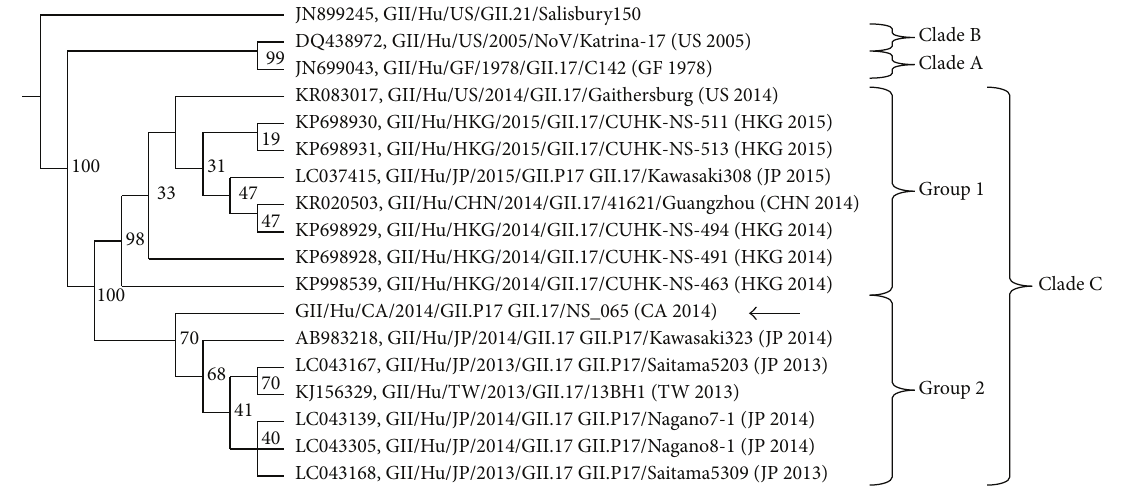
Figure 2: Phylogenetic analysis of the full length VP1 nucleotide sequences of various noroviruses. Presented is a cladogram with supporting bootstrap values. Arrows indicating the location of the Nova Scotia